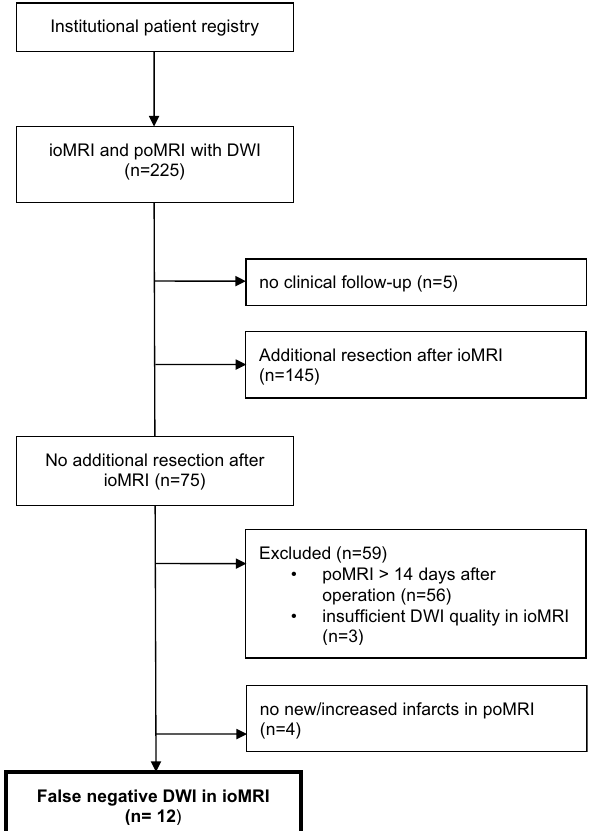
Figure 1. Flowchart of patient inclusion criteria. ioMRI intraoperative MRI, poMRI postoperative MRI, DWI diffusion-weighted